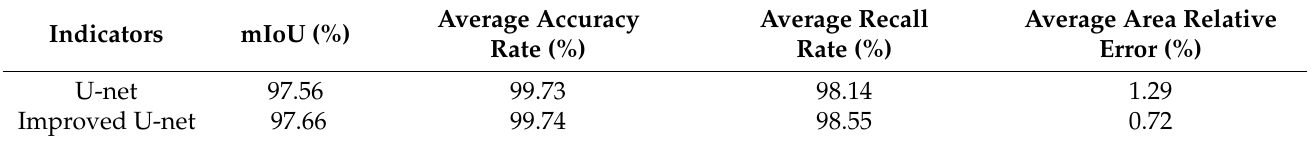
Table 2. Numerical comparison of two networks on four metrics when the fish are placed